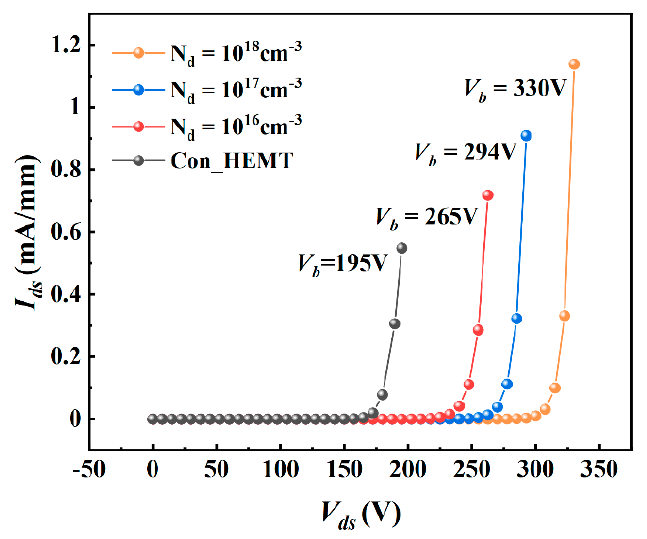
Figure 5. Simulated breakdown characteristics of the proposed structure with different doping concentration.